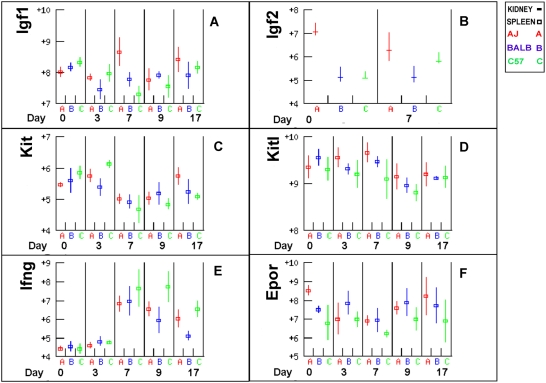
Genes that mediate haematopoiesis.
Igf1 appears to be an important regulator of erythropoiesis in some anaemic patients. Epor, Kit and Kitl are regulators of erythropoiesis. Ifng down-regulates Epor and Kitl and the expression of the three genes was consistent with this relationship.